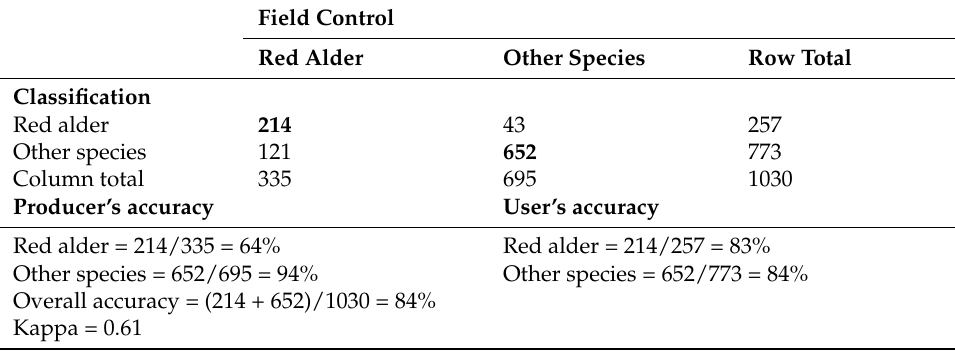
Table 13. Confusion matrix for red alder trees based on the Dalponte2016 segmentation method. Species were modeled based on mean return intensity. Segments were classified using a logistic generalized linear mixed model with a plot held as a random